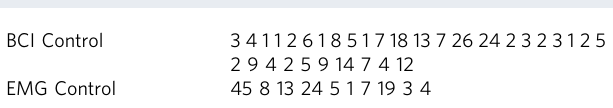
Table 2 Object Release Times.